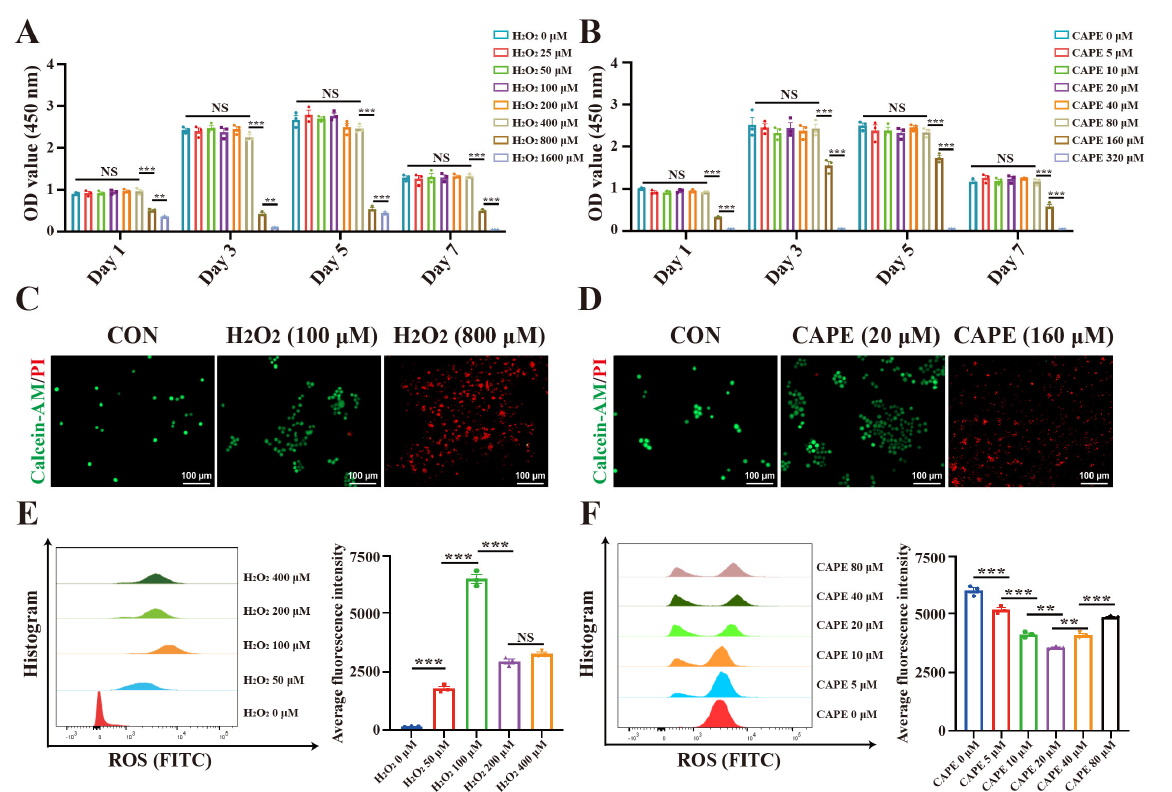
Figure 6. CAPE alleviates H 2 O 2 -induced ROS generation in BV2 cells. ( A ) Cell viability of